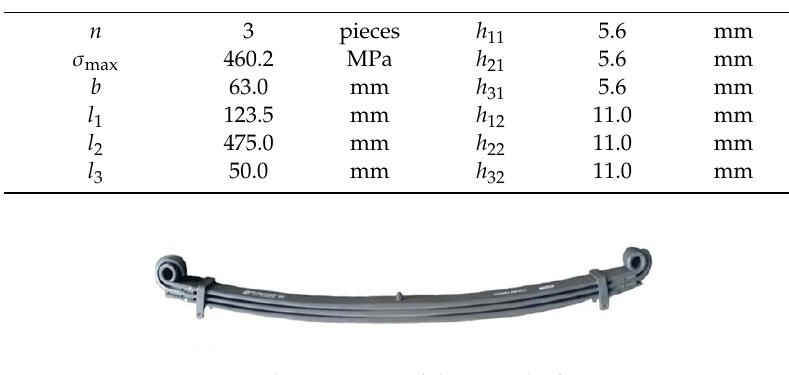
Figure 4. The prototype of the taper-leaf spring. Table 1. The design parameters values.